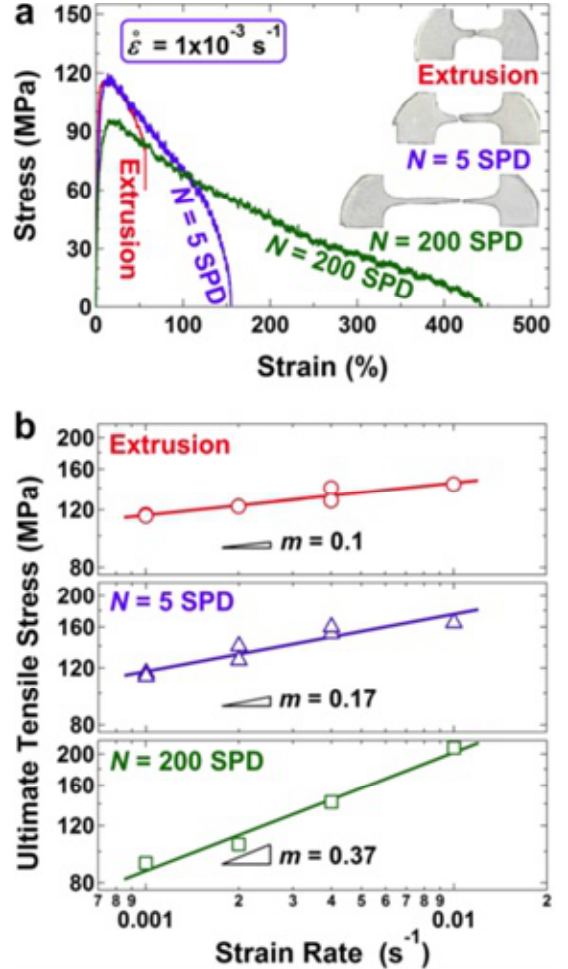
Fig. 2. Tensile plasticity and strain-rate sensitivity enhances after SPD processing in Mg – 7% Li al- loy. Results of tensile tests performed at 300K for the samples processed by extrusion and SPD for N = 5 and 200 cycles. (a) Stress-strain curves meas- ured at a strain rate of 1 × 10 -3 s -1 . Inset: appear- ance of tensile specimens after pulling to failure. (b) Ultimate tensile stress as a function of strain rate; the slopes represent the strain-rate sensitivity, m. The sample after 200 SPD cycles exhibits room- temperature superplasticity with m =